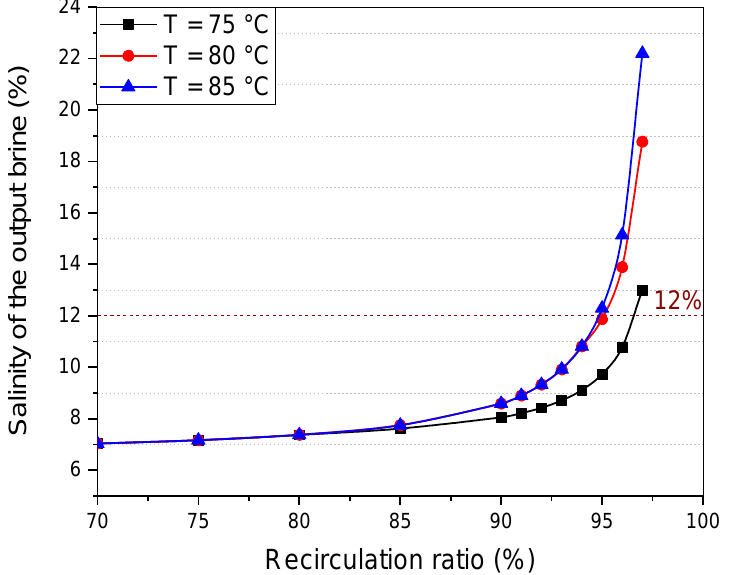
Figure 6. Salinity of the output liquid brine as recirculation increases for varying set-point tempera- ture of the heat pump.